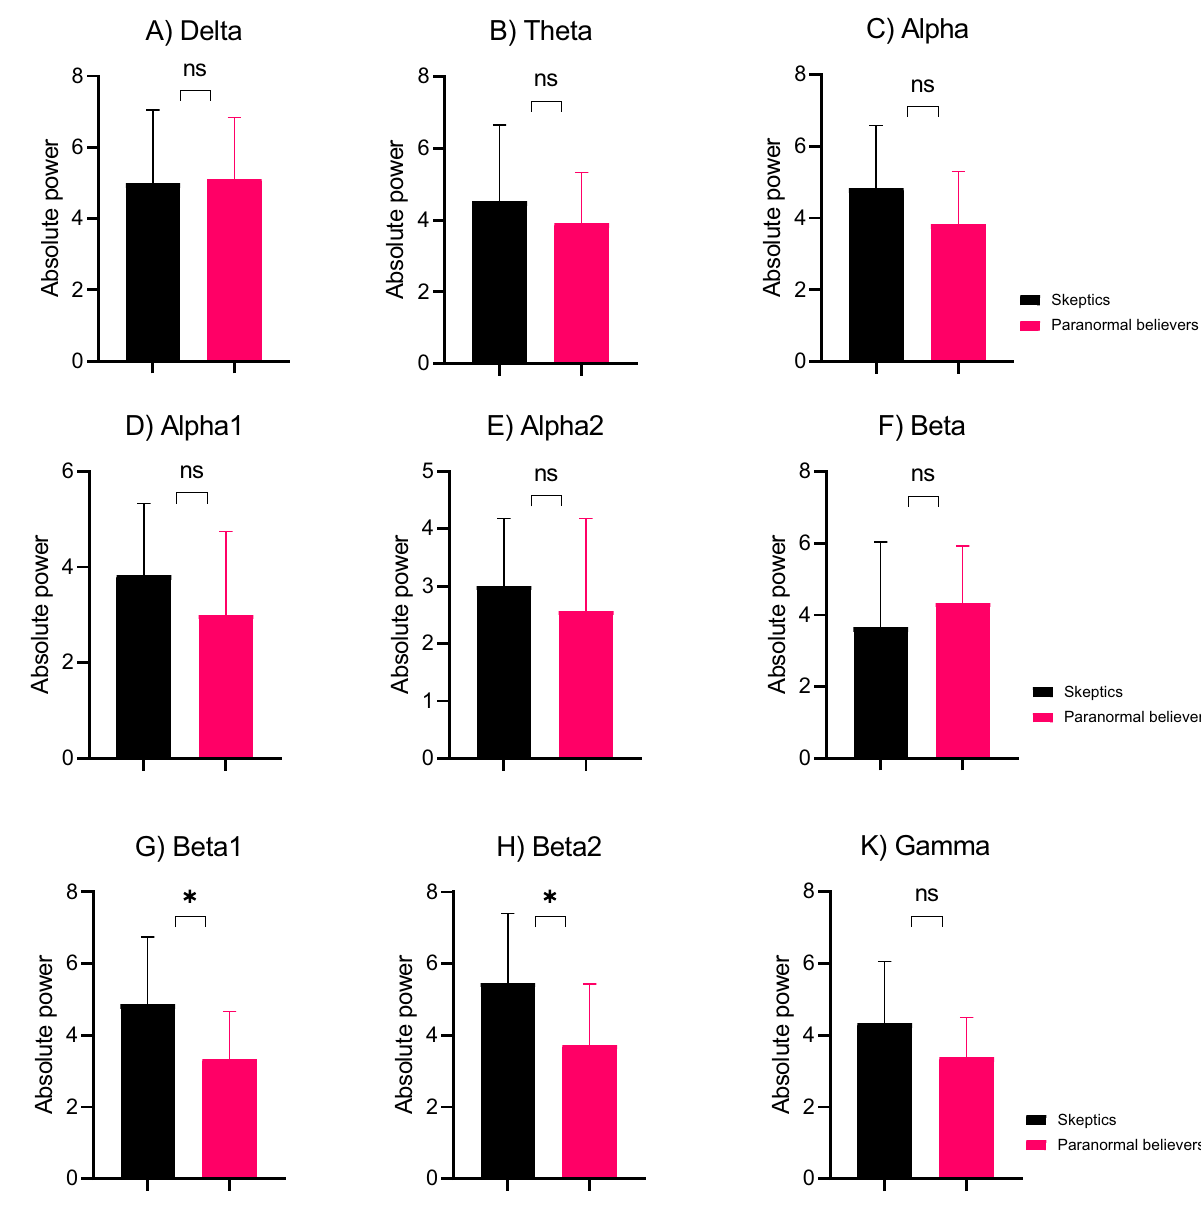
Figure 3. The absolute power of EEG frequency bands in the paranormal believers and skeptics groups in the whole brain. The figures show the absolute power of the bands of ( A ) delta, ( B ) theta, ( C ) alpha, ( D ) alpha1, ( E ) alpha2, ( F ) beta, ( G ) beta1, ( H ) beta2, and ( K ) gamma. The error bars are SD. The black bar charts and red bar charts are for the skeptics and paranormal believers groups, respectively. *P <